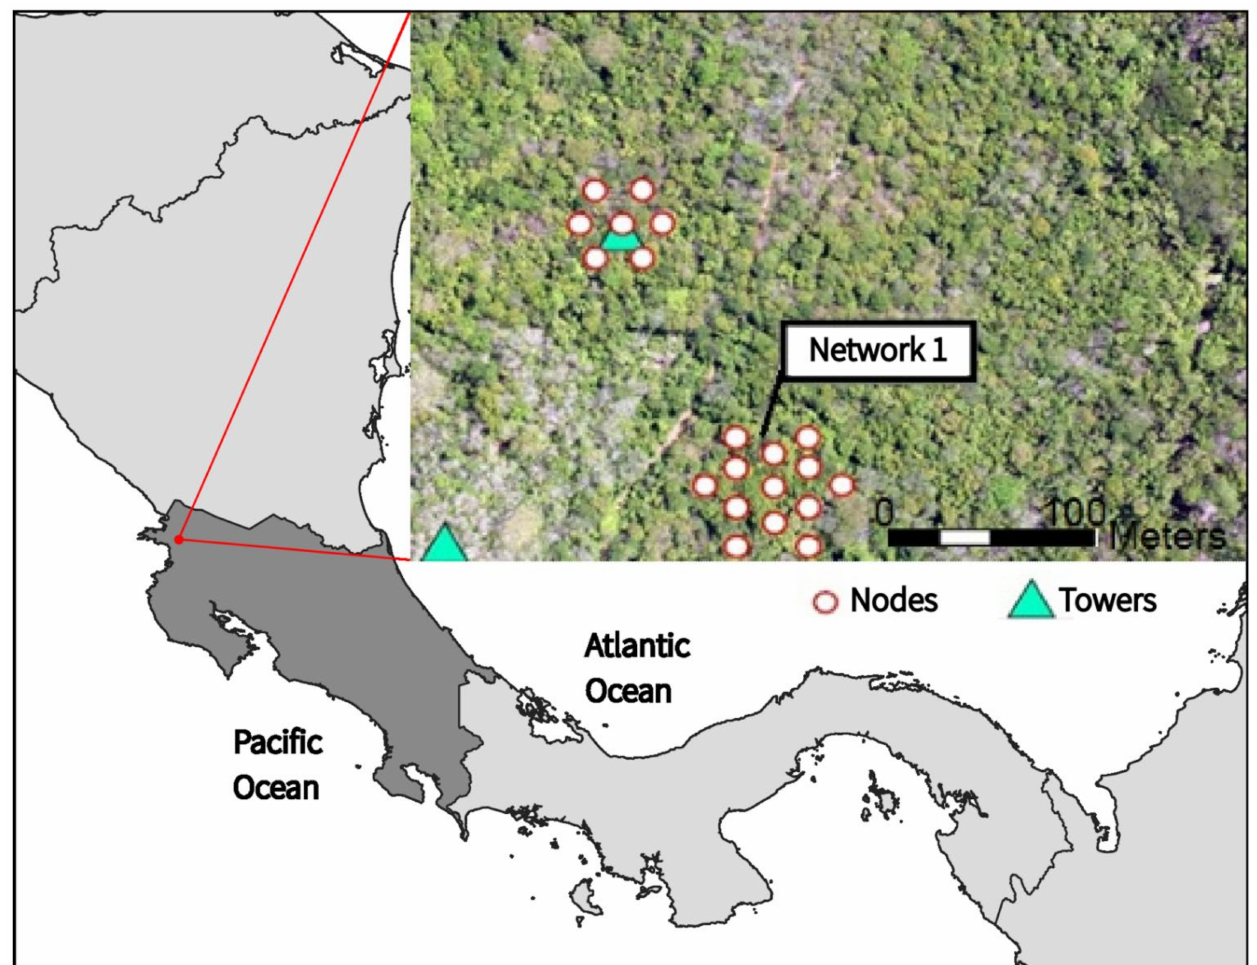
Figure 1. The location of the Santa Rosa National Park—Environmental Monitoring Super Site (SRNP-EMSS), Guanacaste, Costa Rica. Network 1 refers to the WSN that is employed in the creation of the in-situ fPAR